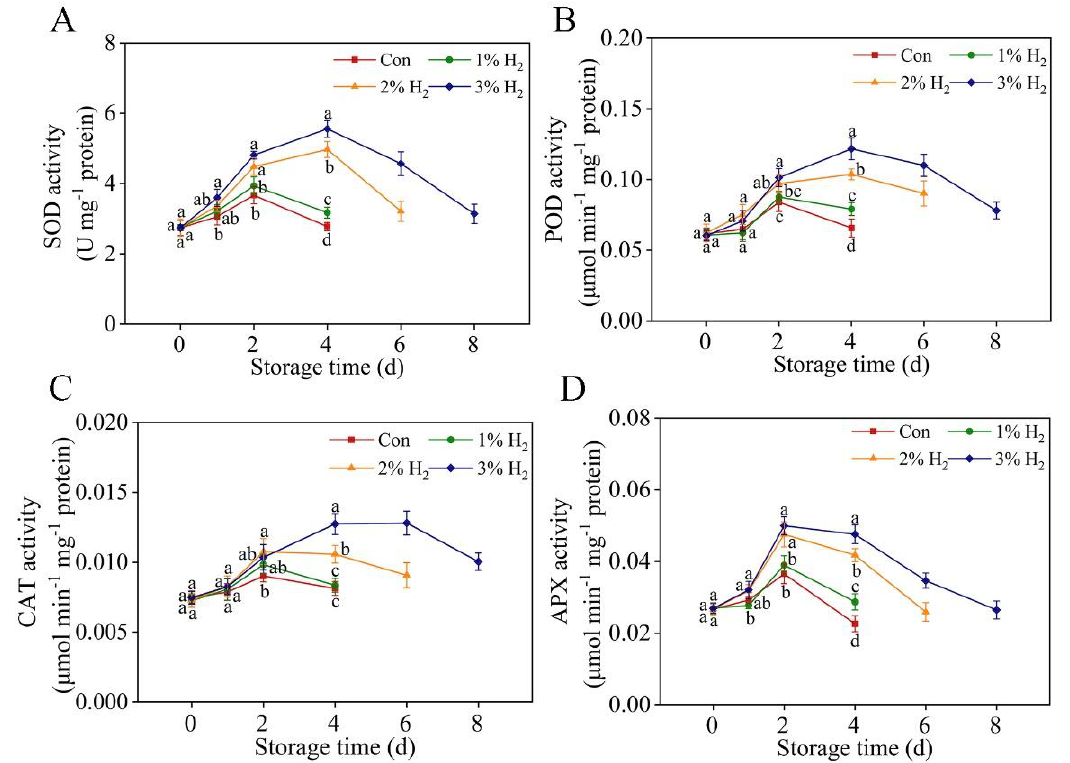
Figure 5. Time-dependent changes of SOD ( A ), POD ( B ), CAT ( C ), and APX ( D ) activities. Chinese chive was stored at 4 ± 1 °C. The enzymatic activities were expressed on a protein mass basis. Means ± SE ( n = 5 for SOD, POD, CAT, and APX activities, respectively) followed by different letters for each storage time indicate a statistical difference at p < 0.05.